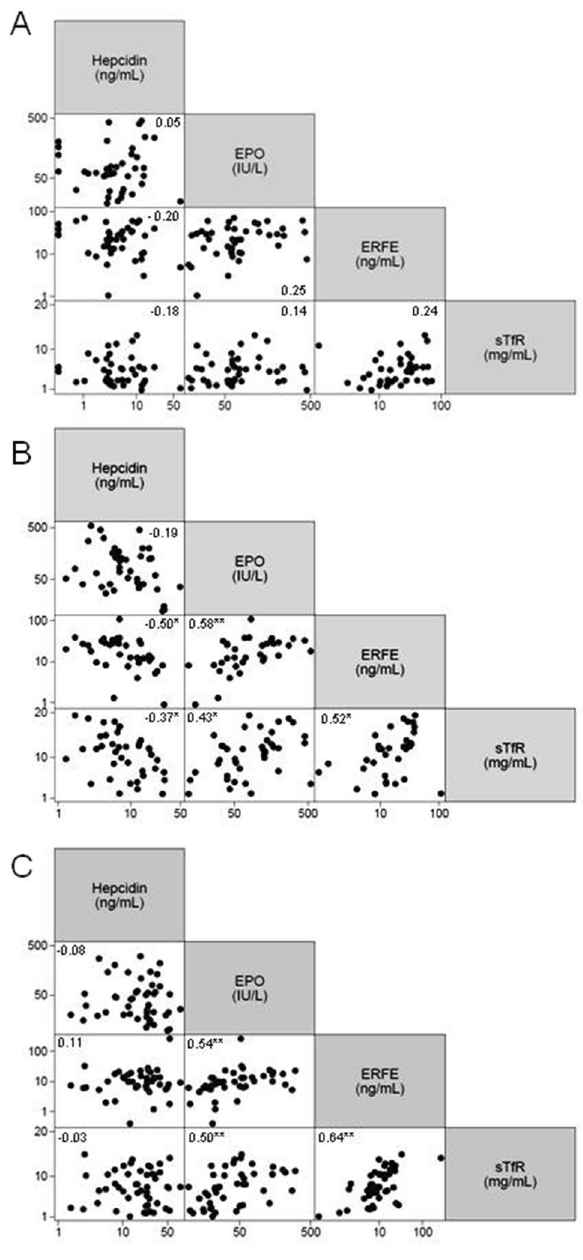
Figure 2. Pairwise correlations between selected variables in CDAII ( A ), PKD ( B ), and HS patients ( C ). Pearson’s r correlation coefficients are indicated in the figure. *P < 0.05 and **P < 0.001. Hepcidin, EPO, and ERFE were ln-transformed.